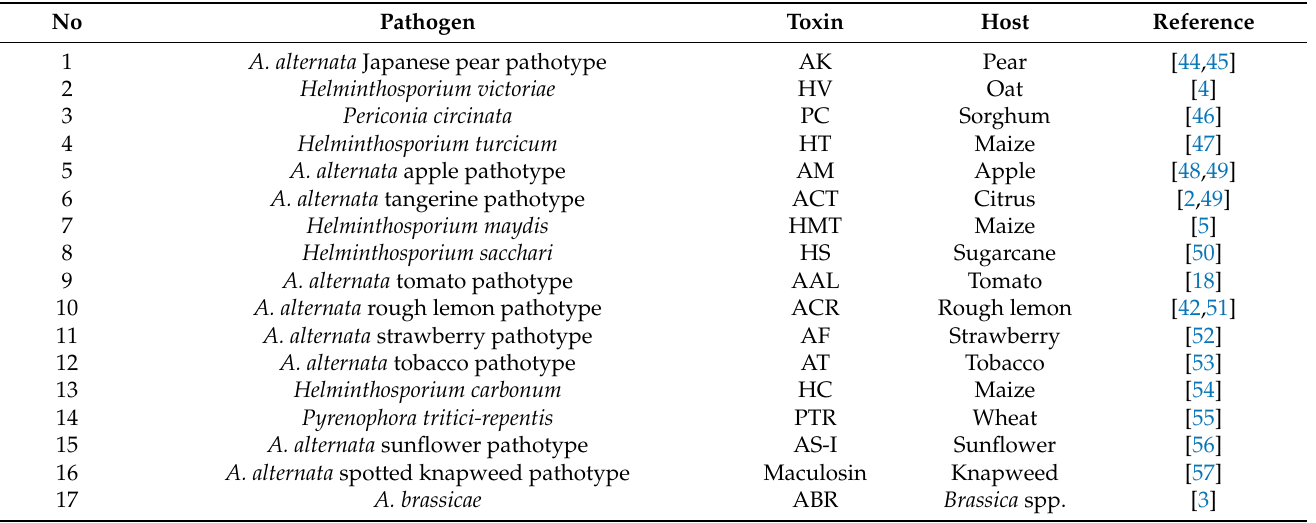
Table 1. Examples of HSTs.